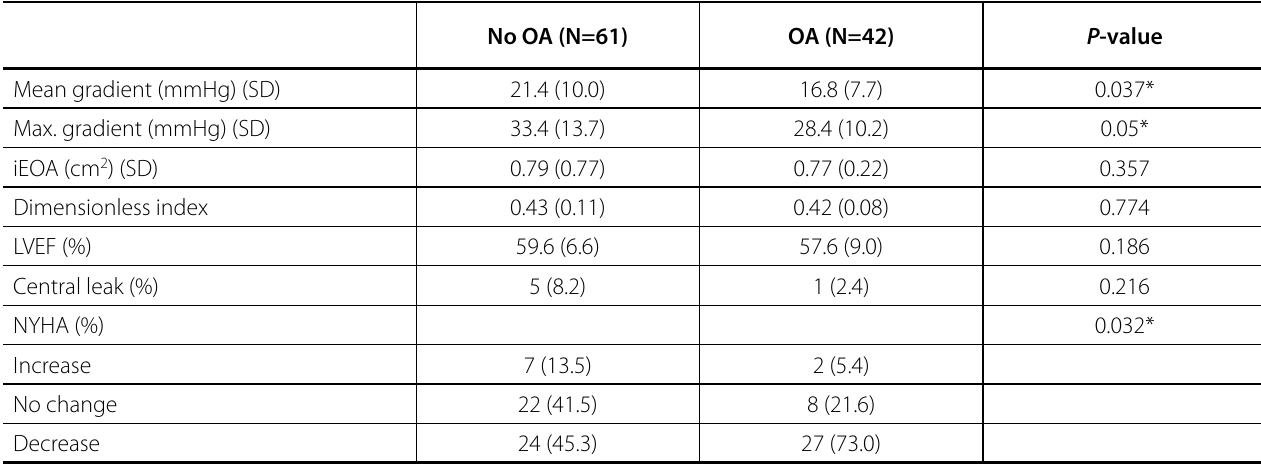
Table 3 . Clinical and echocardiographic